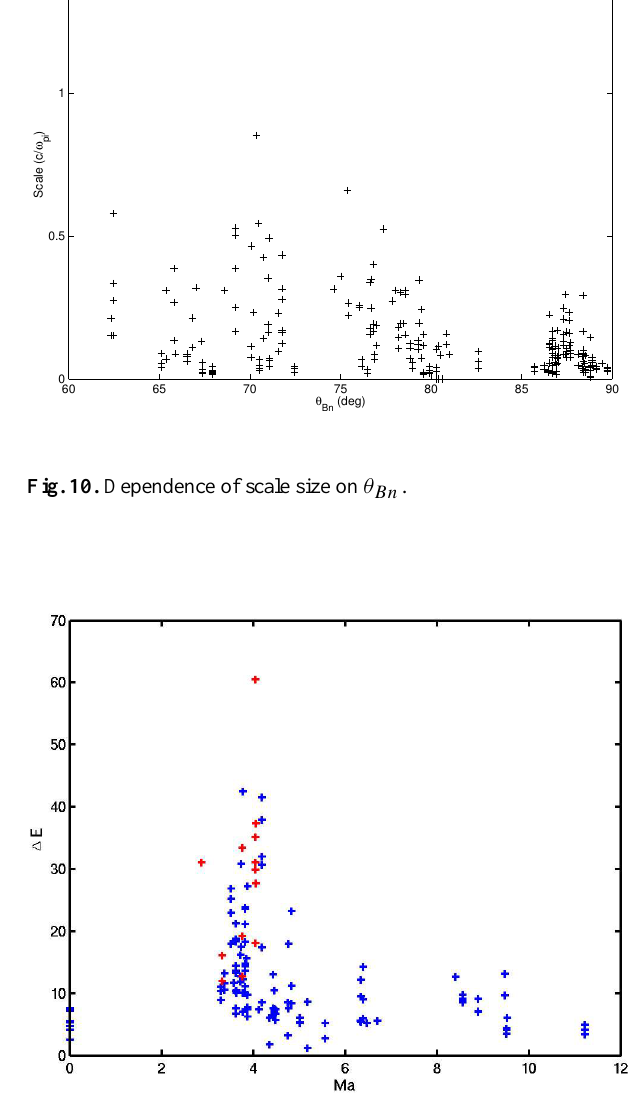
Fig. 9. Dependence of scale size on upstream Mach number.